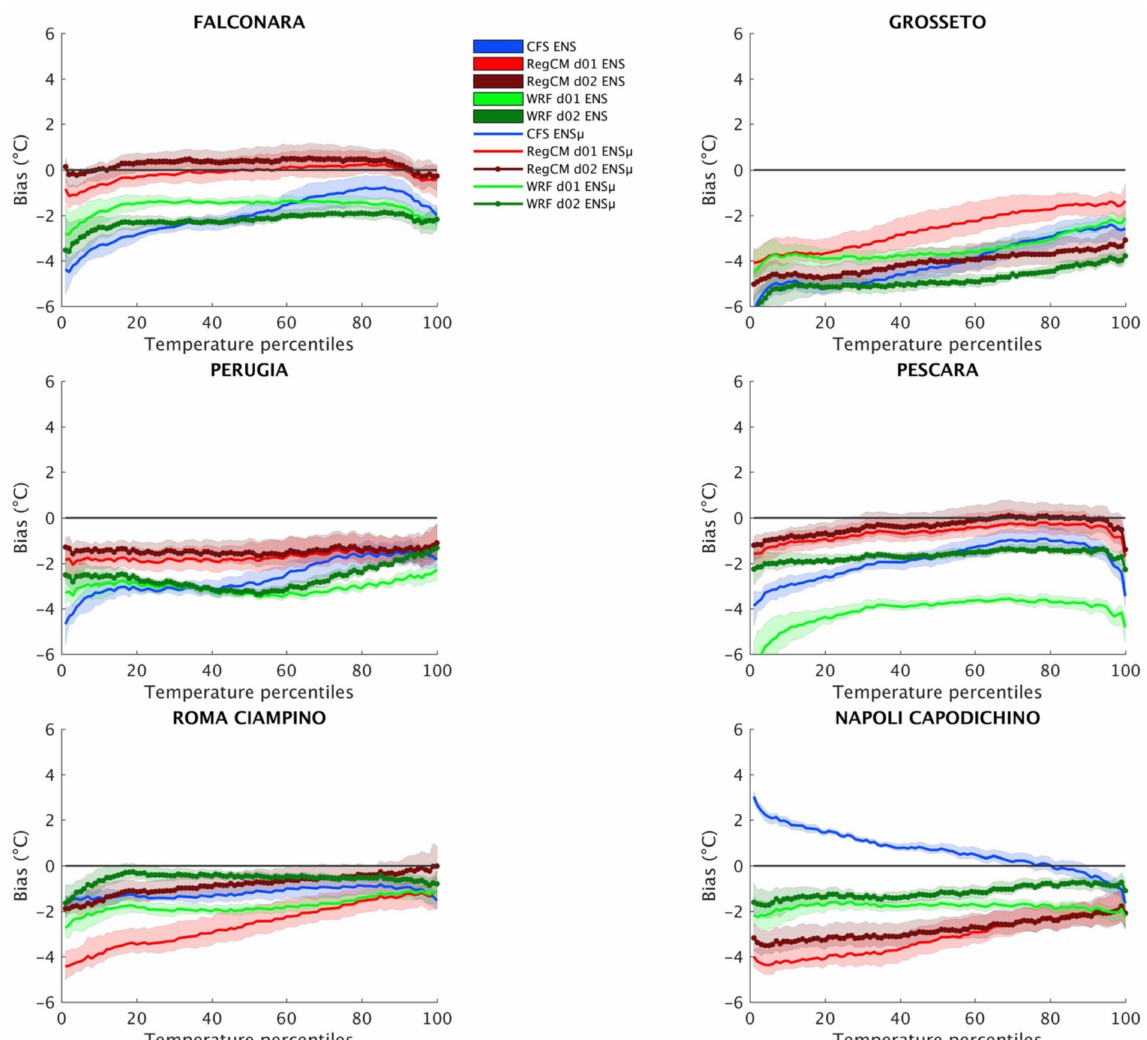
Figure 9. Point-scale evaluation of the percentile-based reference period temperature for the CFS, RegCM and WRF SFSs. Shades represent all ensemble members variability solid lines ensemble means and dotted lines ensemble mean for the RegCM and WRF D02